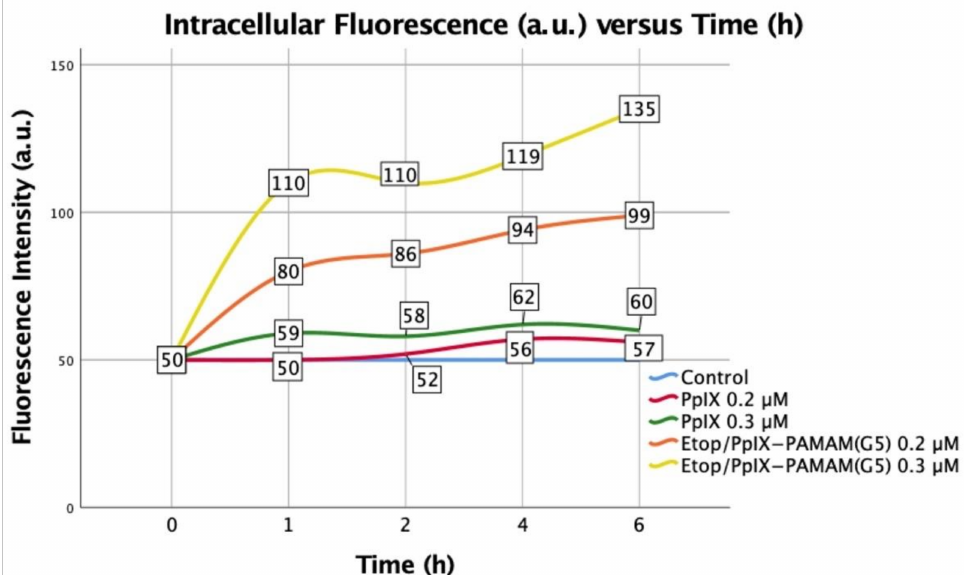
Figure 7. The U87-MG cellular uptake of PpIX and Etop/PpIX-PAMAM(G5) Ns was determined by the fluorescence intensity of PpIX on flow cytometry. The baseline autofluorescence from time 0 h to 6 h was measured at 50 a.u. The uptake with 0.2 µ M of PpIX was slow and minimal, but this was increased when the dose was raised to 0.3 µ M. The uptake of Etop/PpIX-PAMAM(G5) Ns was nearly two times the corresponding dose of PpIX, which appeared rapid within the first hour then more gradually thereafter. (Etop—etoposide, PAMAM(G5) Ns—generation-5 polyamidoamine dendrimer nanosphere, PpIX—protoporphyrin IX).